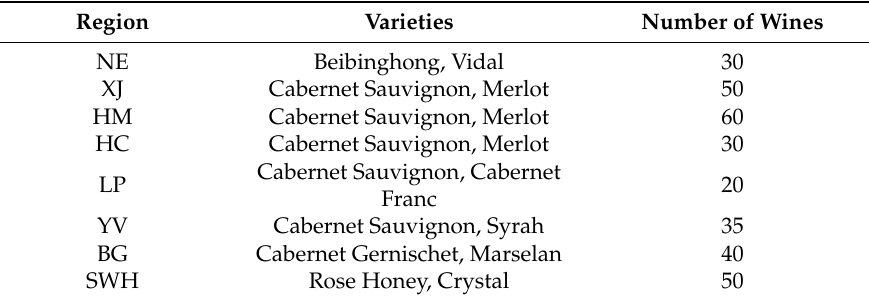
Table 5. The varieties and number of 315 wines in different